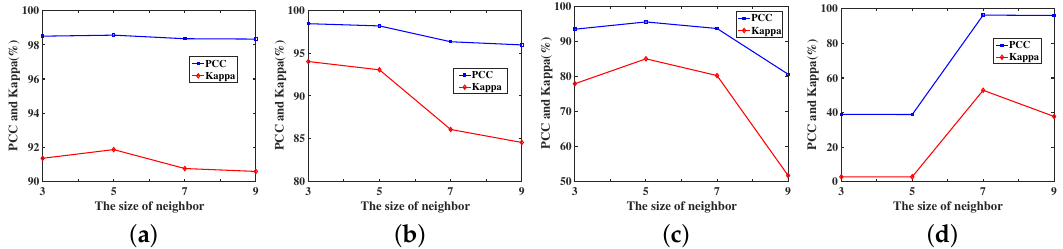
Figure 27. The influence of the size of neighbor window w for PCC, Kappa on different data sets. ( a ) Mexico data set. ( b ) Ottawa data set. ( c ) Yellow River data set. ( d ) Campbell River data